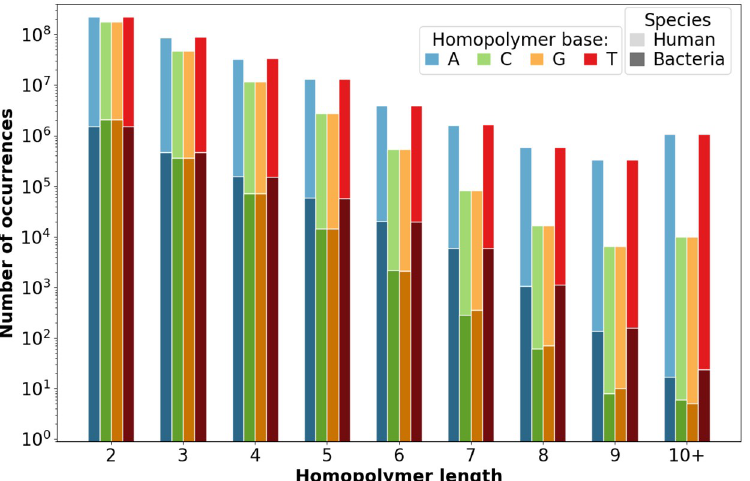
Fig 7. Homopolymer length distribution in bacterial (dark, bottom) and human reference (light, above) genomes. The scale is semi-logarithmic. Occurrences are summed within each category.